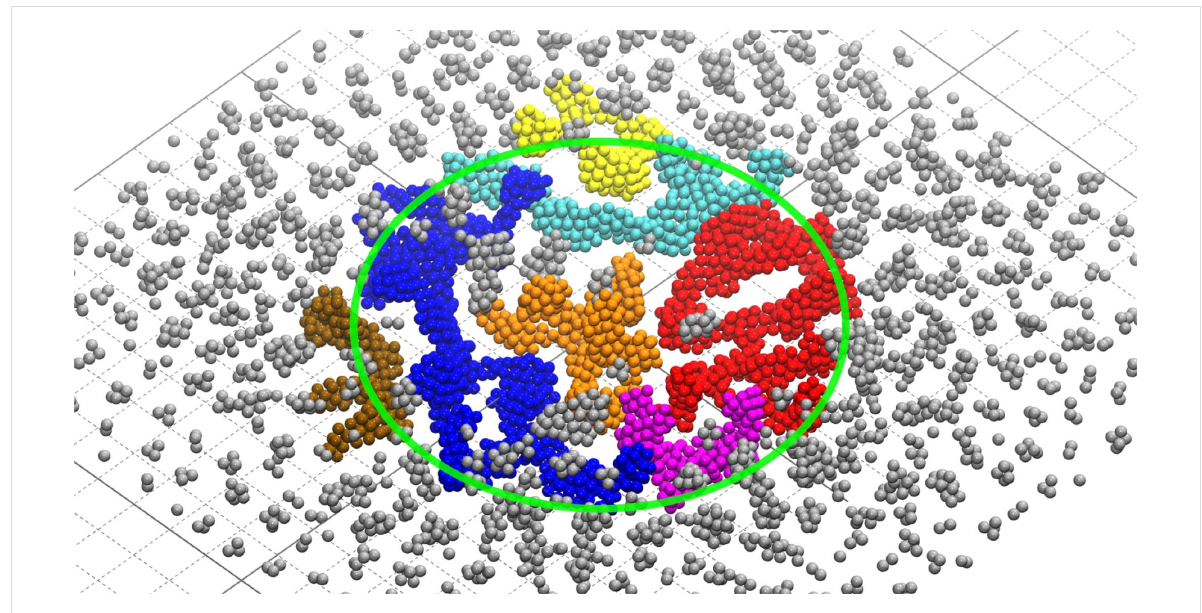
Figure 6: A snapshot of the IDMD simulation of the FEBID process of Pt(PF 3 ) 4 in the regime of E dep = 300 kcal/mol at an electron fluence of 8 × 10 18 cm − 2 . Only Pt atoms are shown. Separate clusters of a size larger than 150 atoms are shown in different colors, while smaller clusters are shown in grey. The green circle indicates the PE beam spot. The grid spacing is 1 nm.